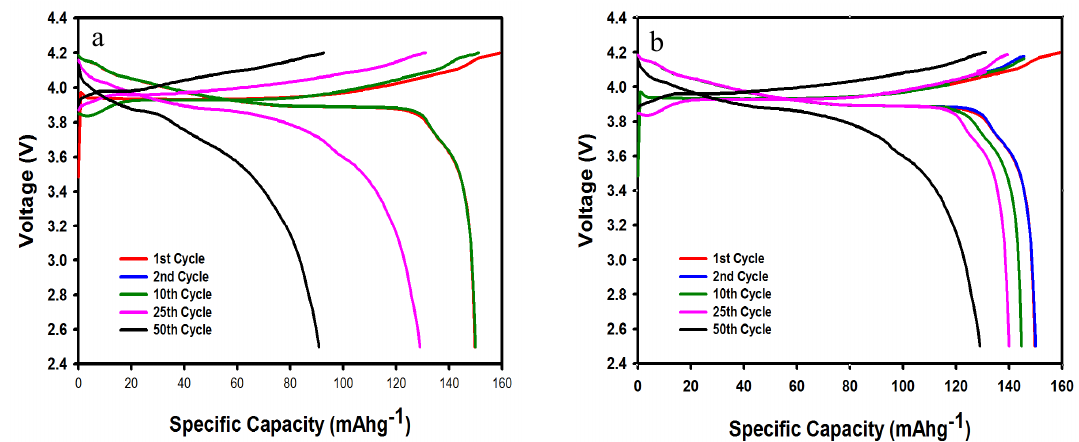
Figure 6. Charge / discharge profiles of a commercial LiCoO 2 cathode at 60 ◦ C with MOILEs ( a ) 1 M Figure 6. Charge/discharge profiles of a commercial LiCoO 2 cathode at 60 ° C with MOILEs ( a ) 1 M LiTFSI LiTFSI 60% EMI-TFSI 40% EC / DMC EC / DMC (1:1 v / v ), and ( b ) 1 M LiTFSI 60% EMI-TFSI 40% EC / DMC 60% EMI-TFSI 40% EC/DMC EC/DMC (1:1 v/v), and ( b ) 1 M LiTFSI 60% EMI-TFSI 40% EC/DMC EC/DMC EC / DMC (1:1 v / v ) containing 5 wt% SN. Current density = 100 mA g − 1 . (1:1 v/v) containing 5 wt% SN. Current density = 100 mA g − 1 .